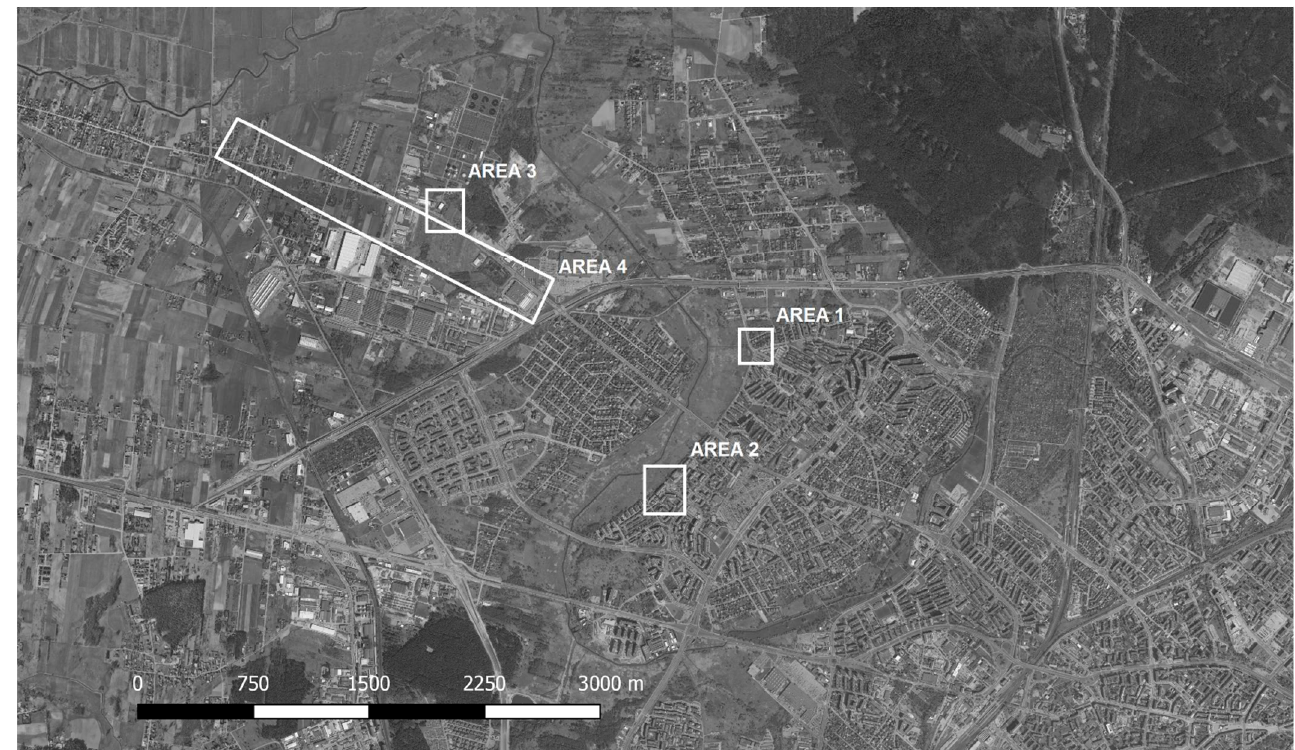
Figure 1. Areas of the research with the specification of key sampling locations.